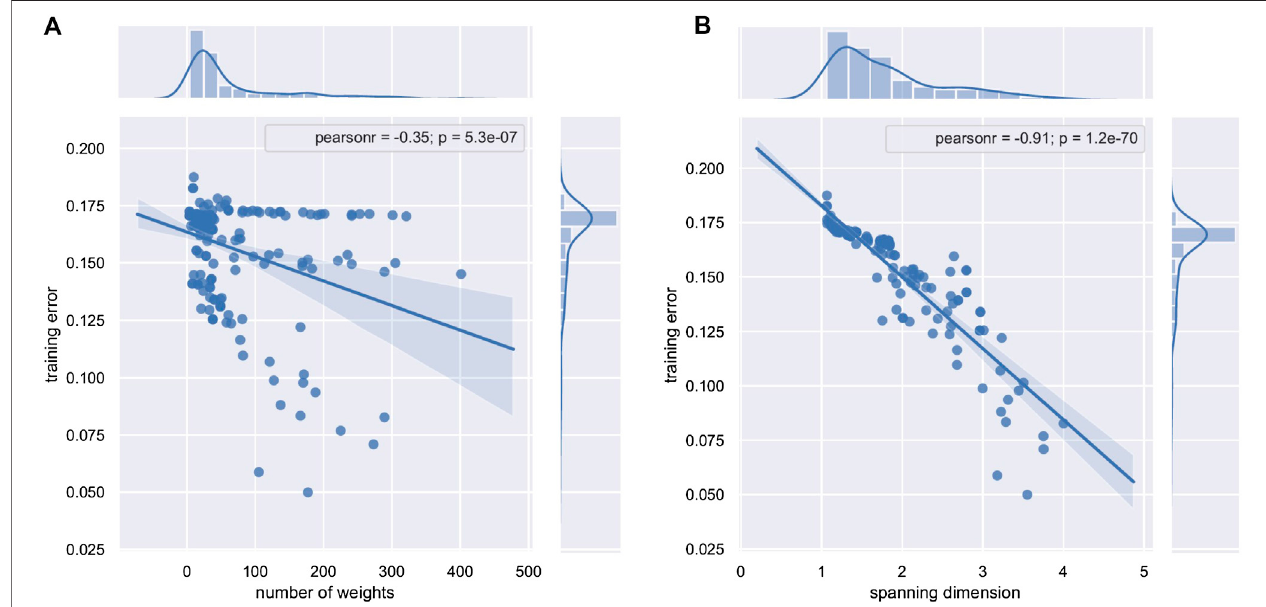
FIGURE 3 | Training error vs. (A) number of trainable weights and (B) ESD for 200 randomly generated multilayer